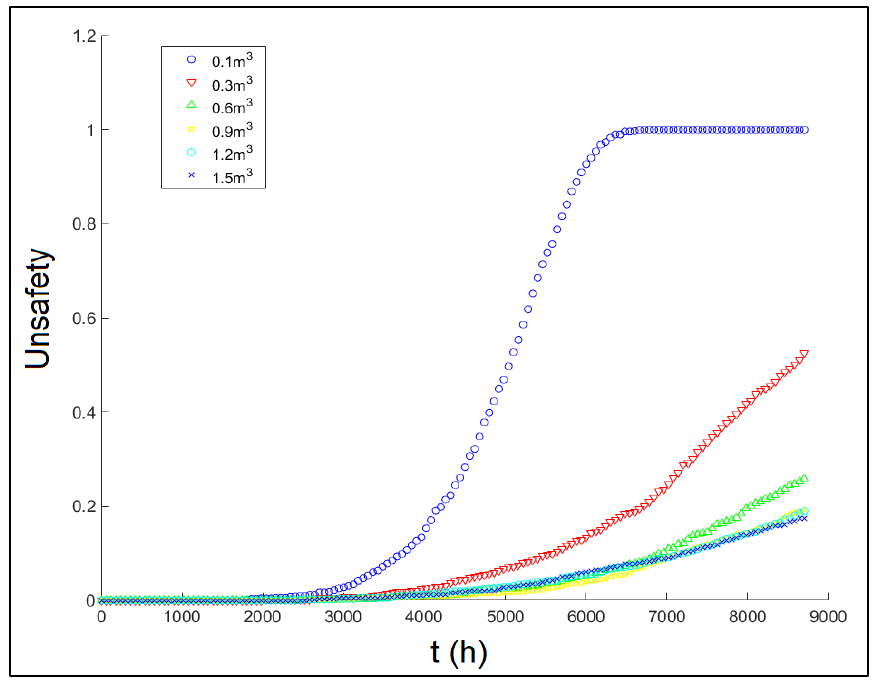
Figure 20. Unsafety of the process of distillation.